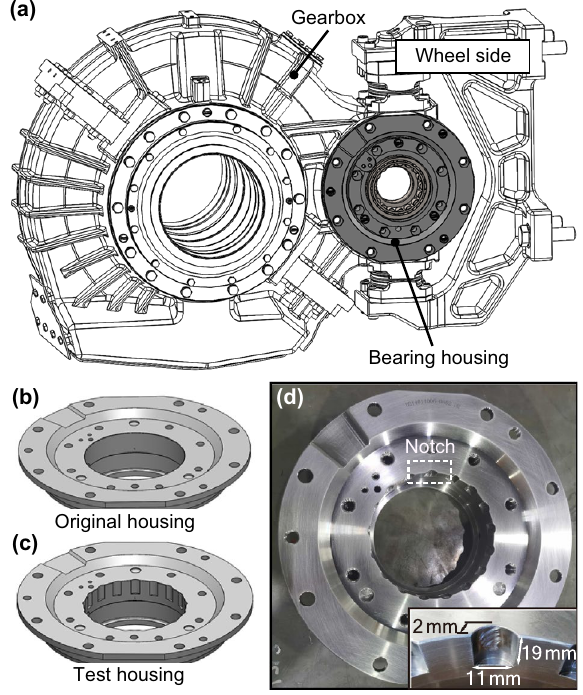
Fig. 3 Position and instrumentation of the test bearing housing: a position of the test bearing housing; b original housing; c modified housing; d photo of the modified housing and its